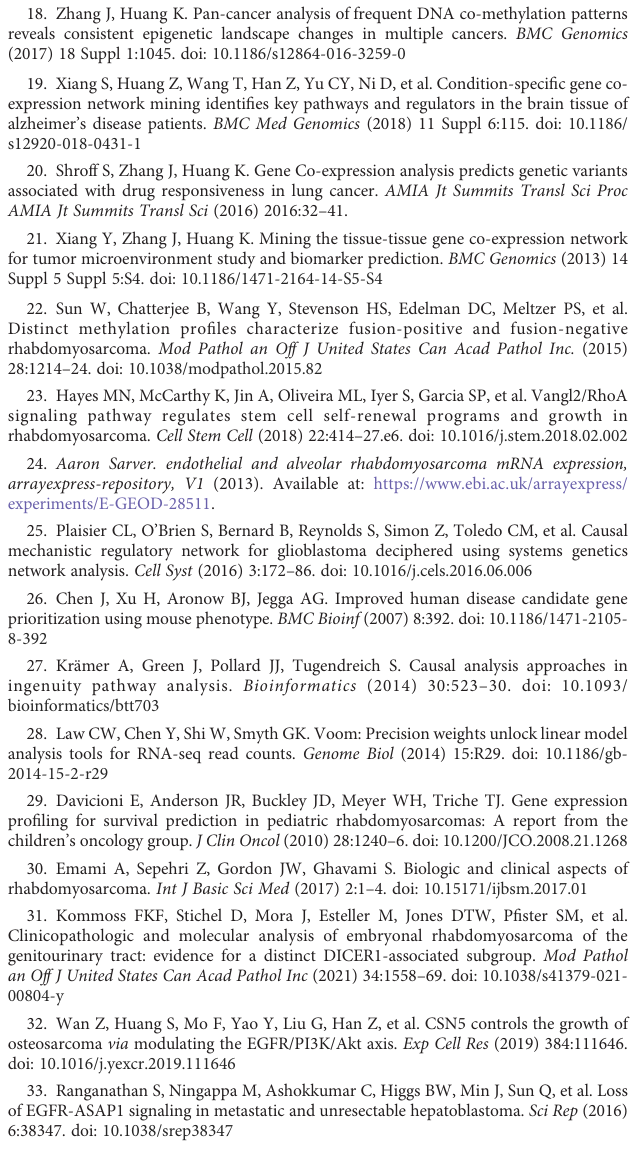
SUPPLEMENTARY TABLE 4 Cytoband enrichment for Module 2 DEGs between FN-RMS and normal tissue. SUPPLEMENTARY TABLE 5 The molecular patterns of the fi ve fusion status associated modules in St. Jude dataset. xlsx. SUPPLEMENTARY TABLE 6 Chromosome location of St. Jude Module 2 genes with changes in both CNV level and mRNA level. xlsx. SUPPLEMENTARY FIGURE 1 Heatmap of Module 2 differential-expressed genes with respect to normal